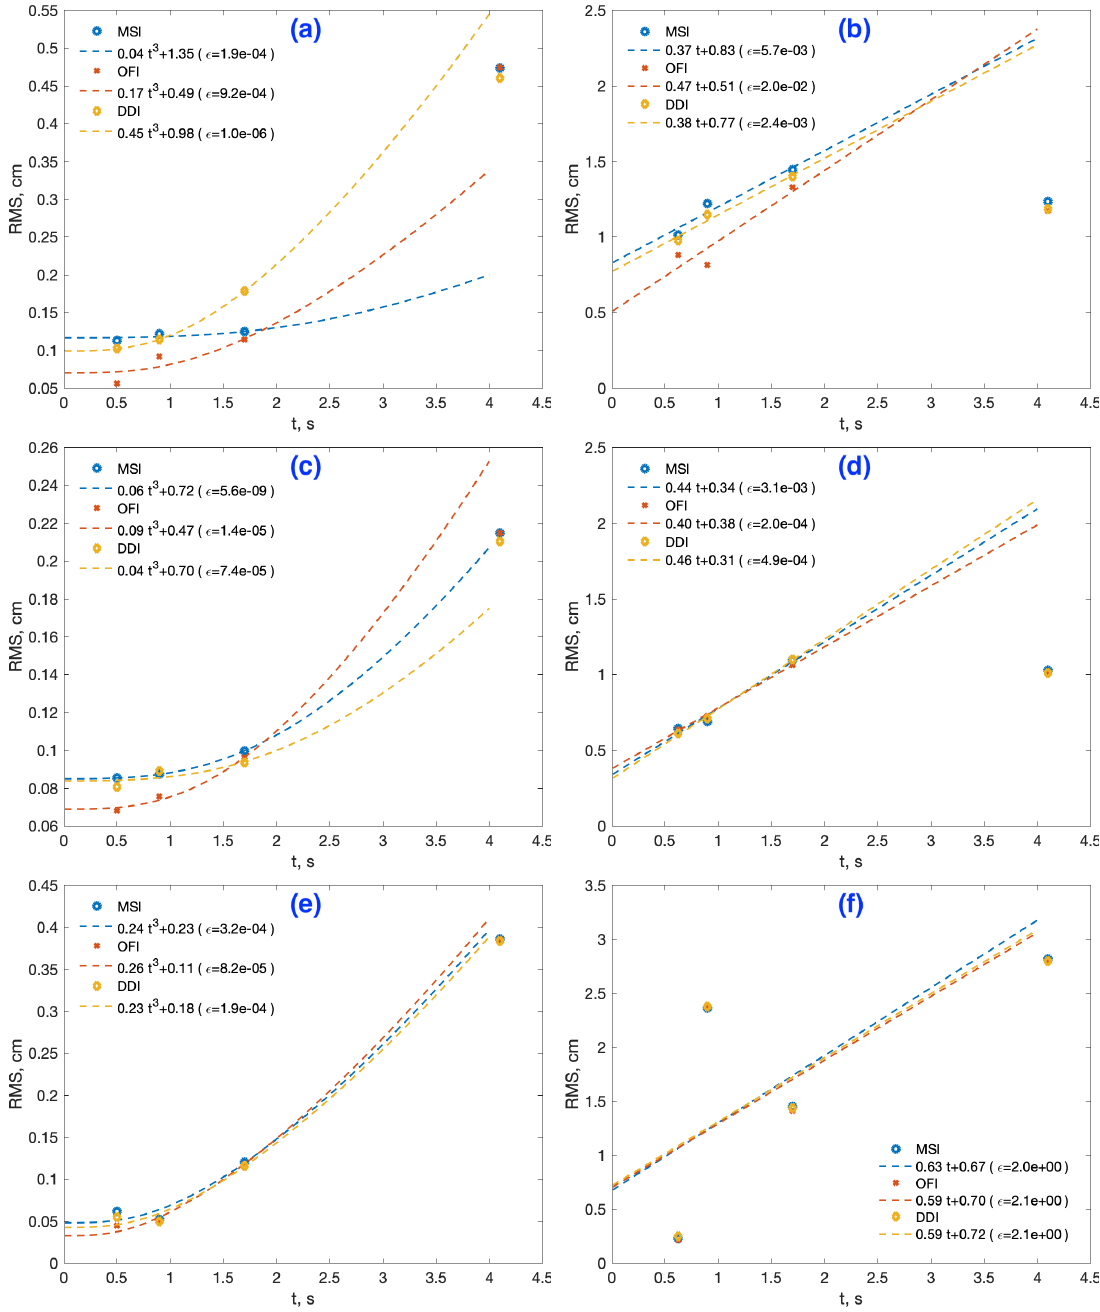
Figure 5. RMS position error for the Accel.XS ( first row ), Accel.LS ( second row ) and Accel.WR ( third row ) devices: numerical result of the estimations and interpolated model for small integration times (under 2 s). ( Left ) Short distance estimations. ( Right ) Large distance